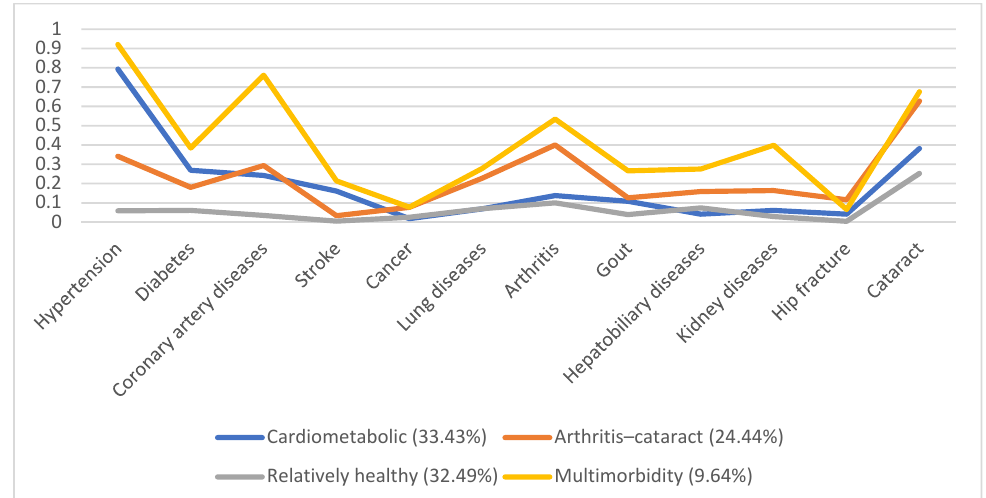
Figure 3. Multimorbidity patterns in 2003.